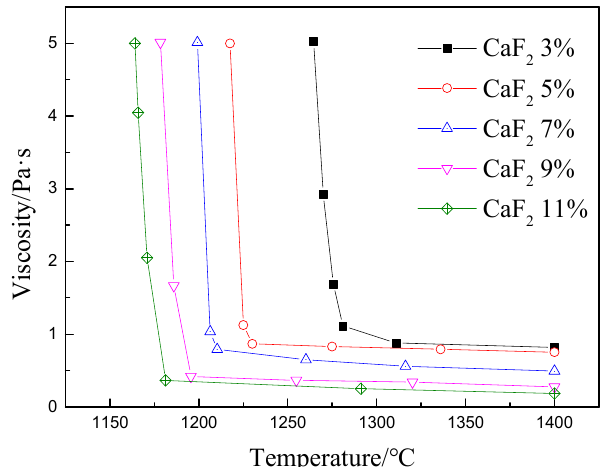
Figure 5. Viscosity temperature curve at different CaF 2 contents.